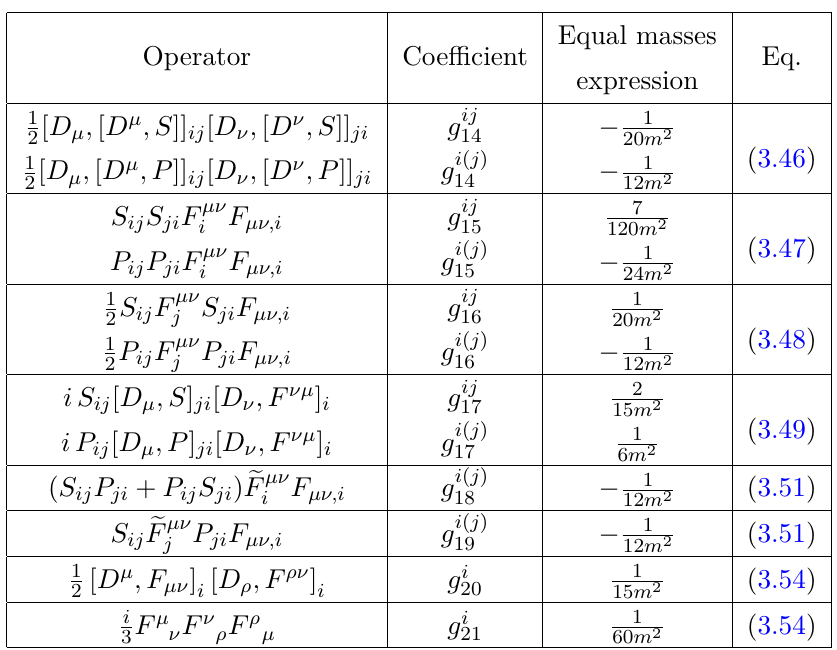
Table 4 . Values of the O ( X 2 D 4 ) , O ( SPD 4 ) , and O ( D 6 ) fermionic universal coefficients in the limit of equal